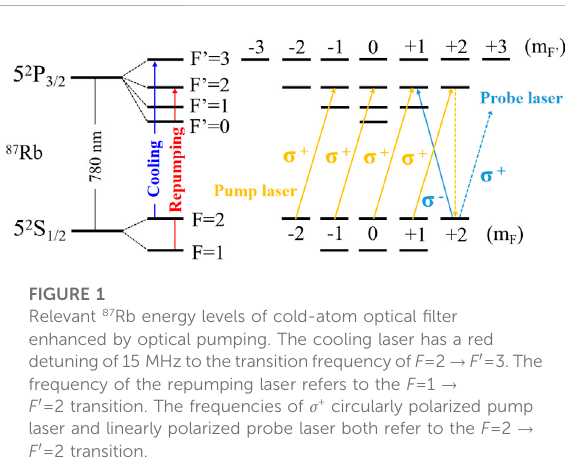
FIGURE 1 Relevant 87 Rb energy levels of cold-atom optical fi lter enhanced by optical pumping. The cooling laser has a red detuning of15 MHz to thetransition frequencyof F =2 → F ′ =3.The frequency of the repumping laser refers to the F =1 → F ′ =2 transition. The frequencies of σ + circularly polarized pump laser and linearly polarized probe laser both refer to the F =2 → F ′ =2